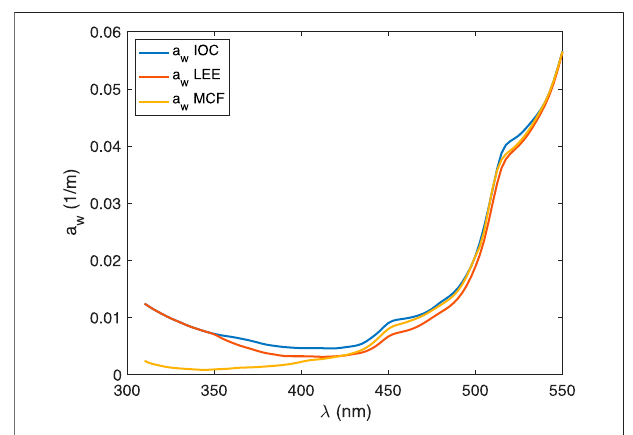
FIGURE 1 | The absorption coef fi cients of pure water from the three sources: IOC, LEE, and